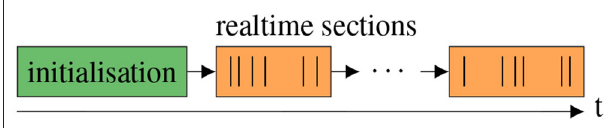
FIGURE 2 | Time evolution of a single execution instance. The initialization is followed by possibly multiple real-time executions with input spike-trains represented by vertical